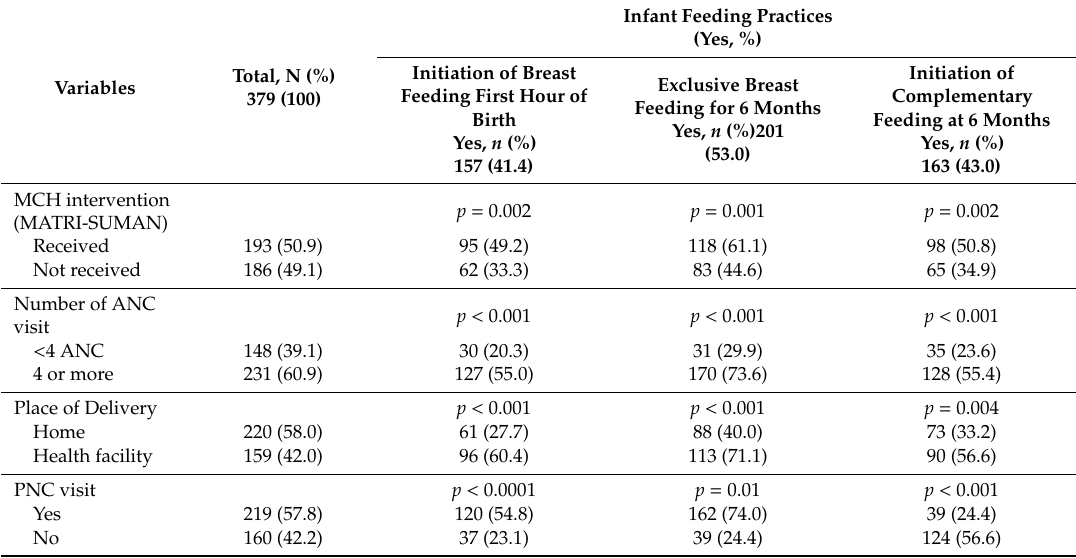
Table 3. Association between utilization of maternal care services and infant feeding practices in rural Southern Nepal, 2016.